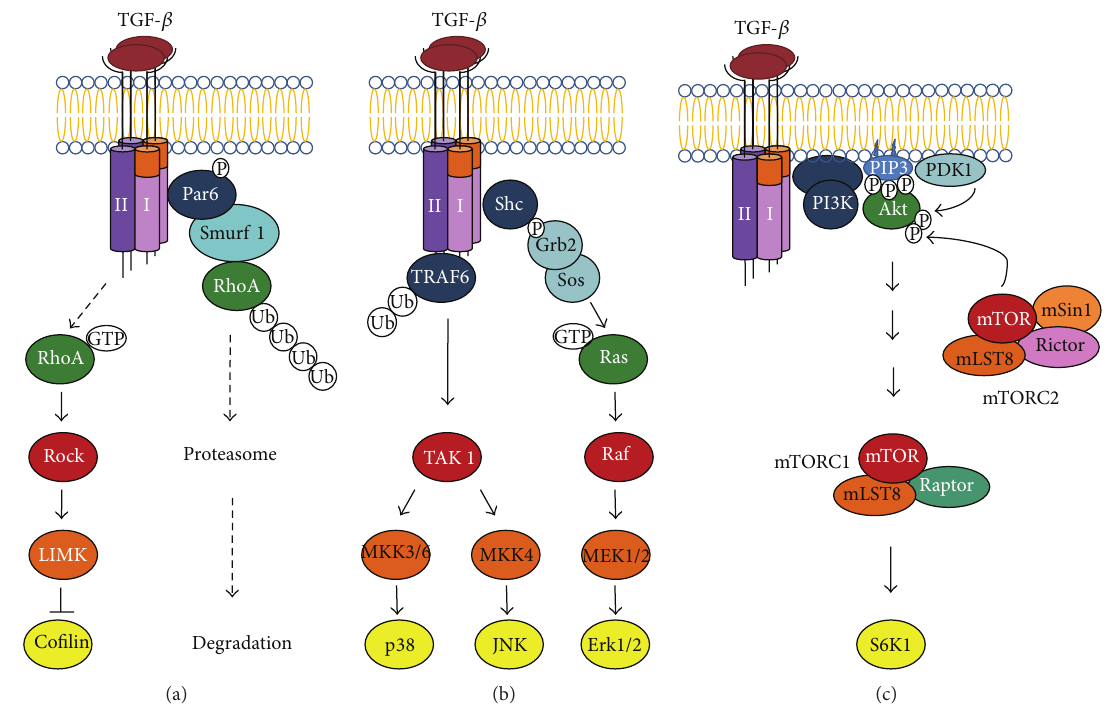
Figure 3: Non-Smad signaling in response to TGF- 𝛽 (according to Xu et al. [94]). (a) Activation of RhoA in response to TGF- 𝛽 and induction of ubiquitin-mediated RhoA degradation at tight junctions. (b) TGF- 𝛽 activates p38 MAP kinase and JNK MAP kinase signaling through the activation of TAK1 (TGF- 𝛽 -activated kinase) by receptor-associated TRAF6, and ERK MAP kinase signaling through recruitment and phosphorylation of Shc by the T 𝛽 R1 receptor. (c) TGF- 𝛽 induces PI3-kinase signaling, leading to the activation of AKT-mTOR signaling and consequently to increased